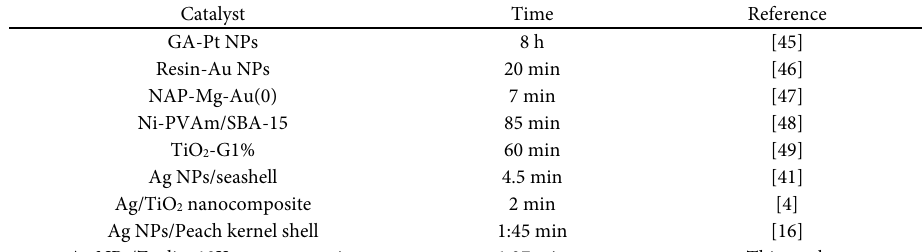
Table 2. Comparison of the catalytic performance of the other catalysts in reduction of 4-NP.